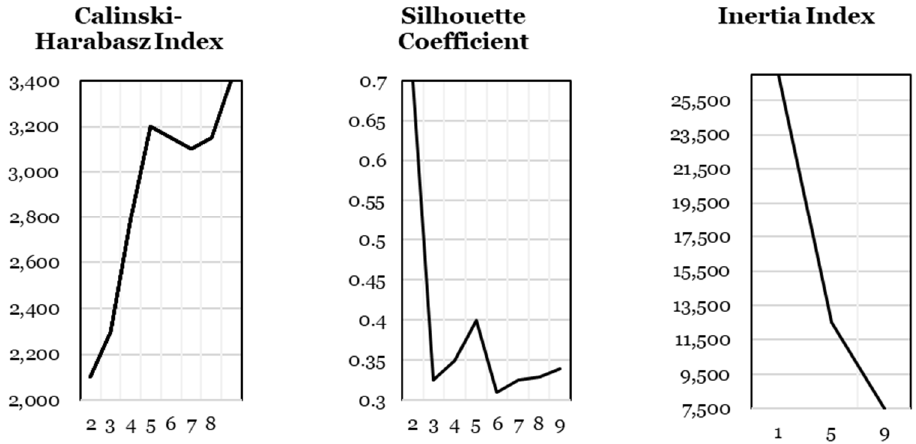
Figure 3. Calinski–Harabasz index, silhouette coefficient and inertia index of k -means clustering. Table 2. Average areas and proportions of five land use types of